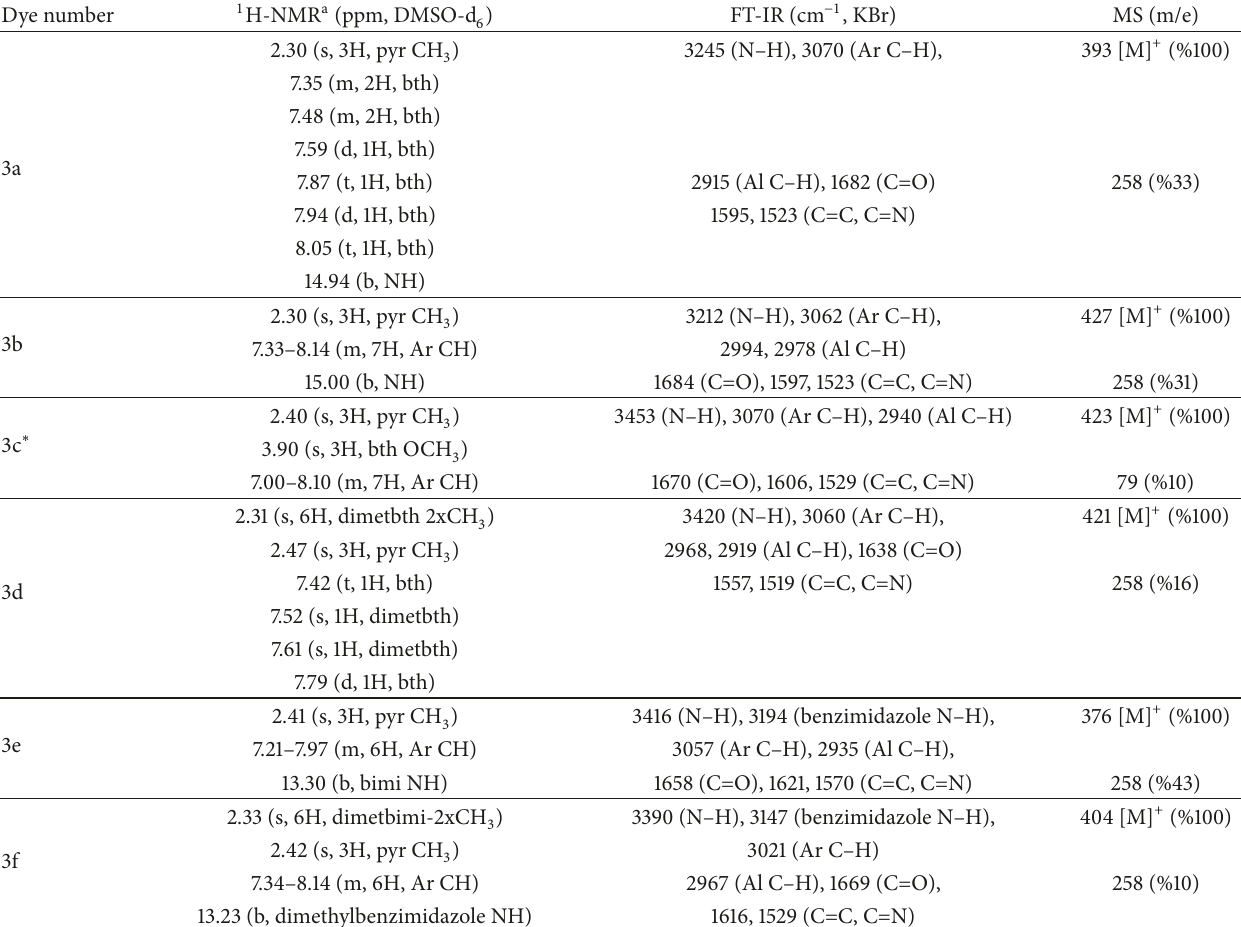
Table 2: Spectral data for dyes